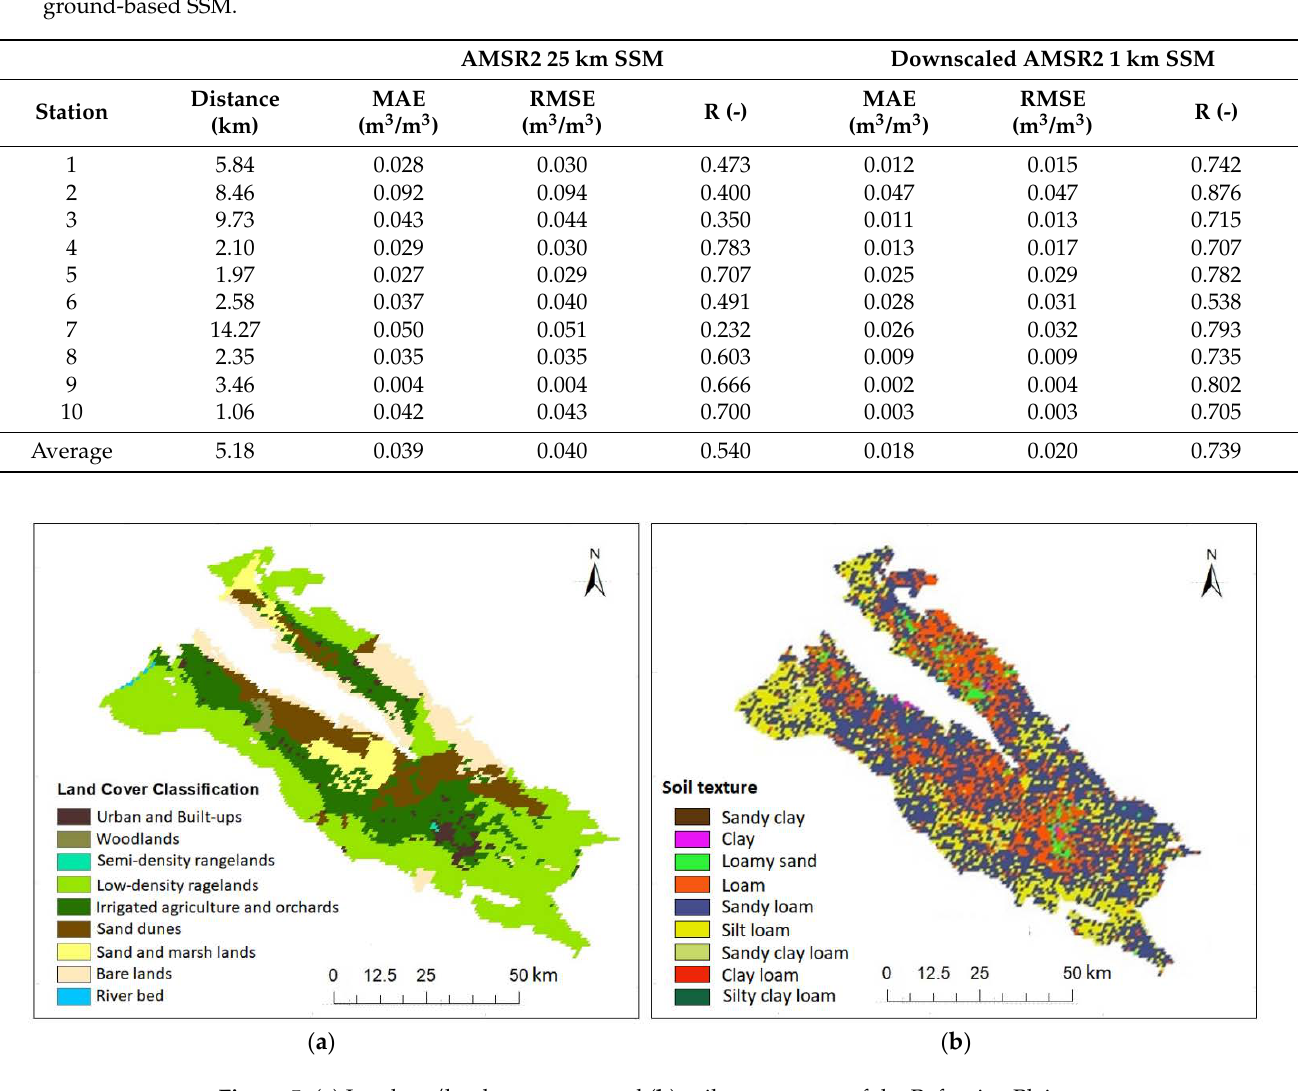
Figure 5. ( a ) Landuse/landcover map, and ( b ) soil texture map of the Rafsanjan Plain.